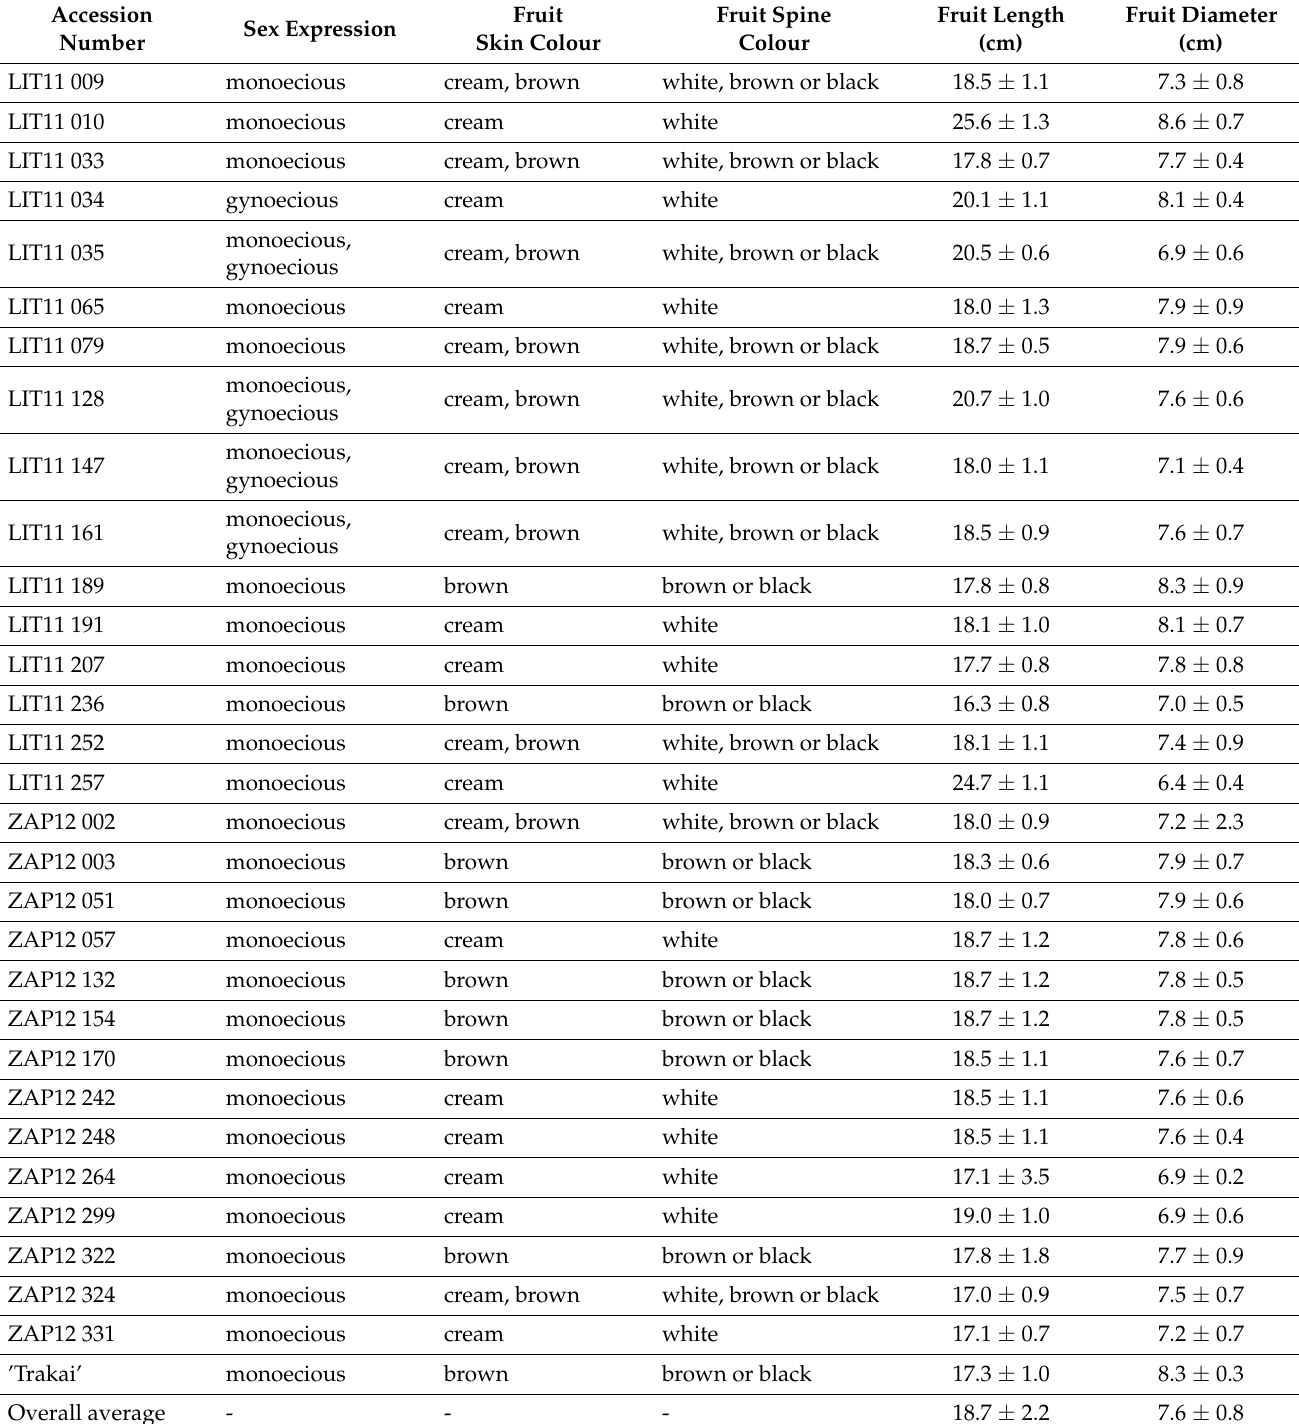
Table 4. Plant sex and mature fruit characteristics of cucumber accessions ( Cucumis sativus